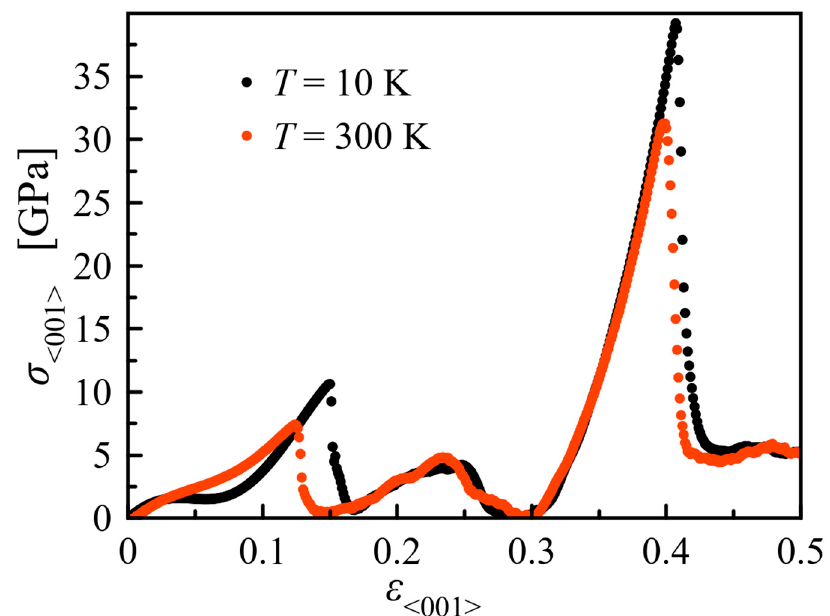
Figure 3. Engineering strain–stress curve for uniaxial compressive loading of TiAl alloy in the <001> direction. The black and red circles represent the loading process at 10 and 300 K, respectively.